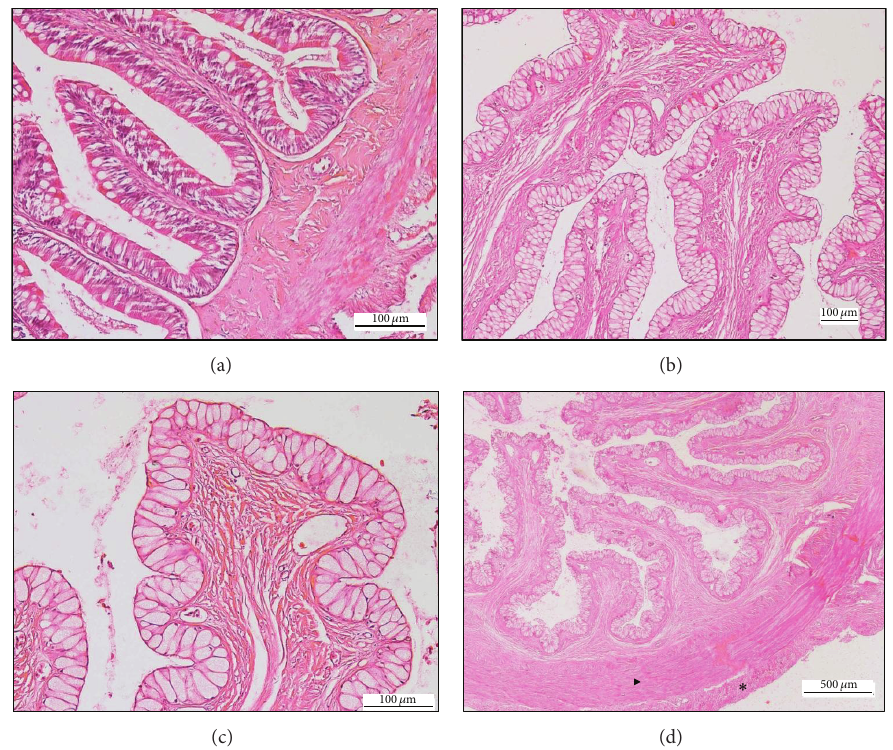
Figure 3: (a) The anterior part of intestine, HE 200x. (b) Goblet cells at the mucosal lining of intestine, HE 100x. (c) Vascularized villi of the intestine, HE 400x. (d) Inner circular ( 󳶳 ) and outer longitudinal muscle ( ∗ ) of intestine, HE